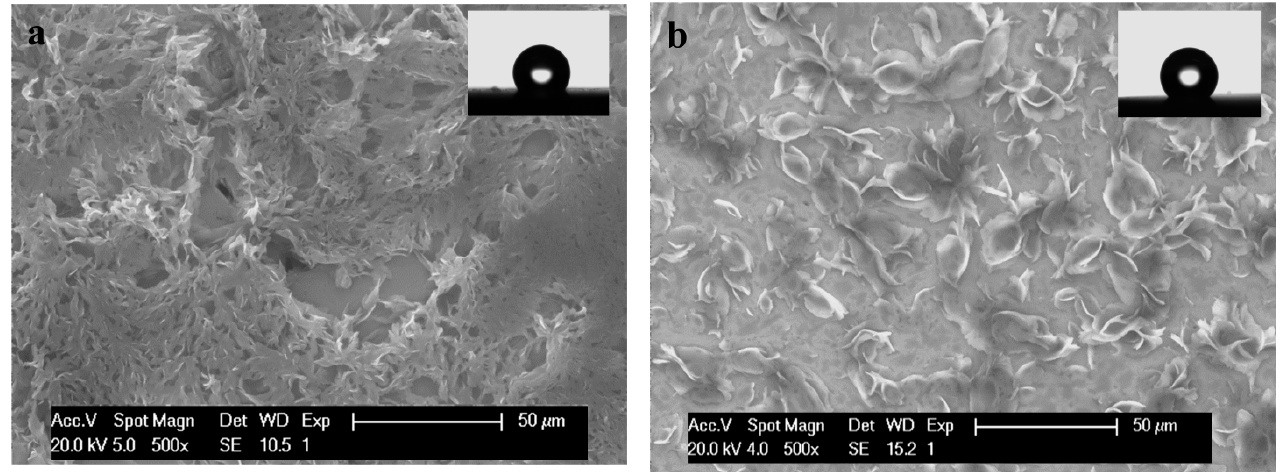
Figure 2. SEM-modified surface of SS type AISI 410S in an SA solution. ( a ) Without (CA = 117.8° ± 2). ( b ) With the addition of 2.0% of E307 after 120 h testing in a simulated solution of acid rain with pH = 3 at 25 °C (CA = 137.2° ± 1).